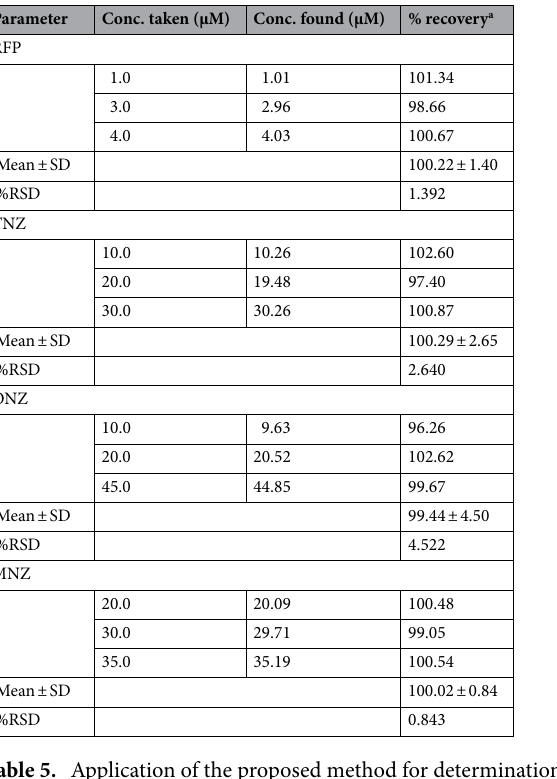
Table 5. Application of the proposed method for determination of the drugs in spiked human plasma samples. a Mean of three